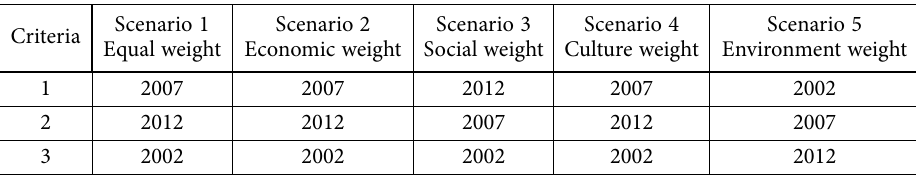
Table 9. Aggregate rankings in different scenarios